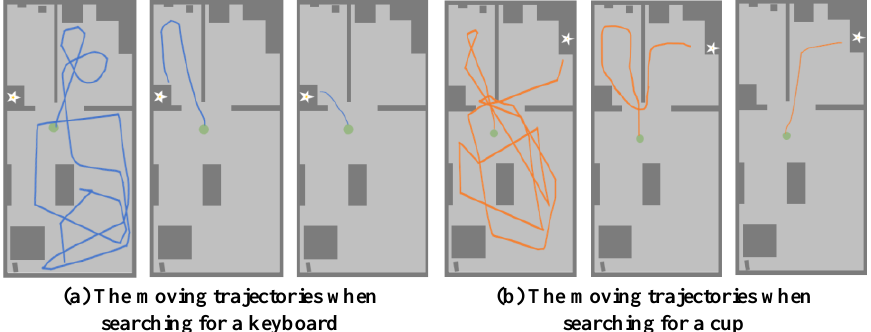
Figure 11. The moving trajectories of the robot. From left to right: Random Search, Traversal Search, and Autonomous Search.